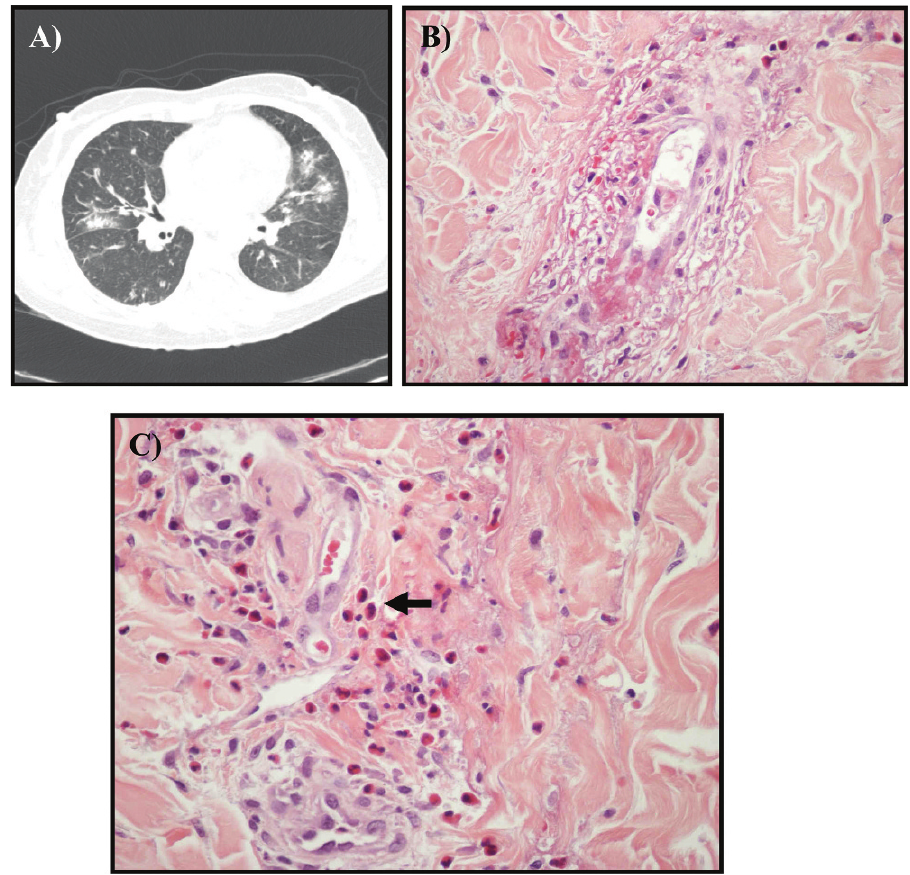
Figure 1 - Panel displaying the thoracic computed tomography findings and the skin histopathology. (A) The thoracic computed tomography scan demonstrates small nodular lesions with discrete ground-glass attenuation. (B) The skin biopsy (hematoxylin-eosin) demonstrates small-vessel vasculitis with eosinophils. (C) Magnification of the inflammatory infiltrate demonstrates the presence of numerous eosinophils